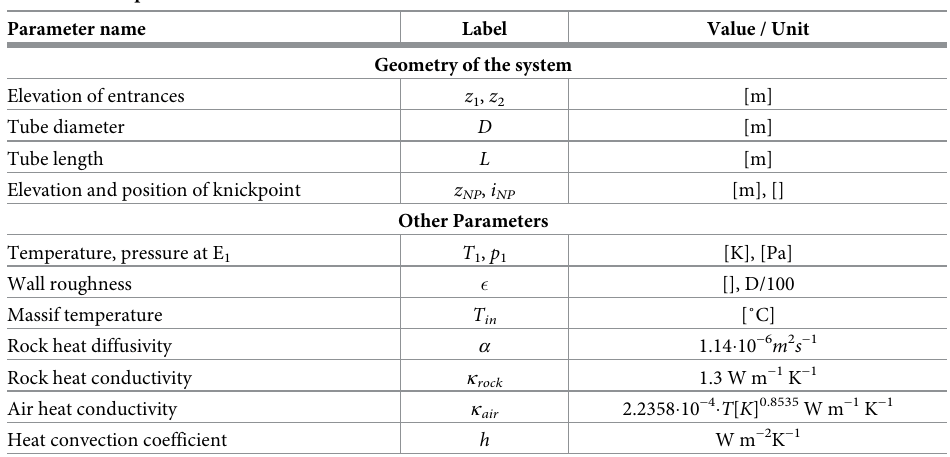
Table 1. Model parameters.